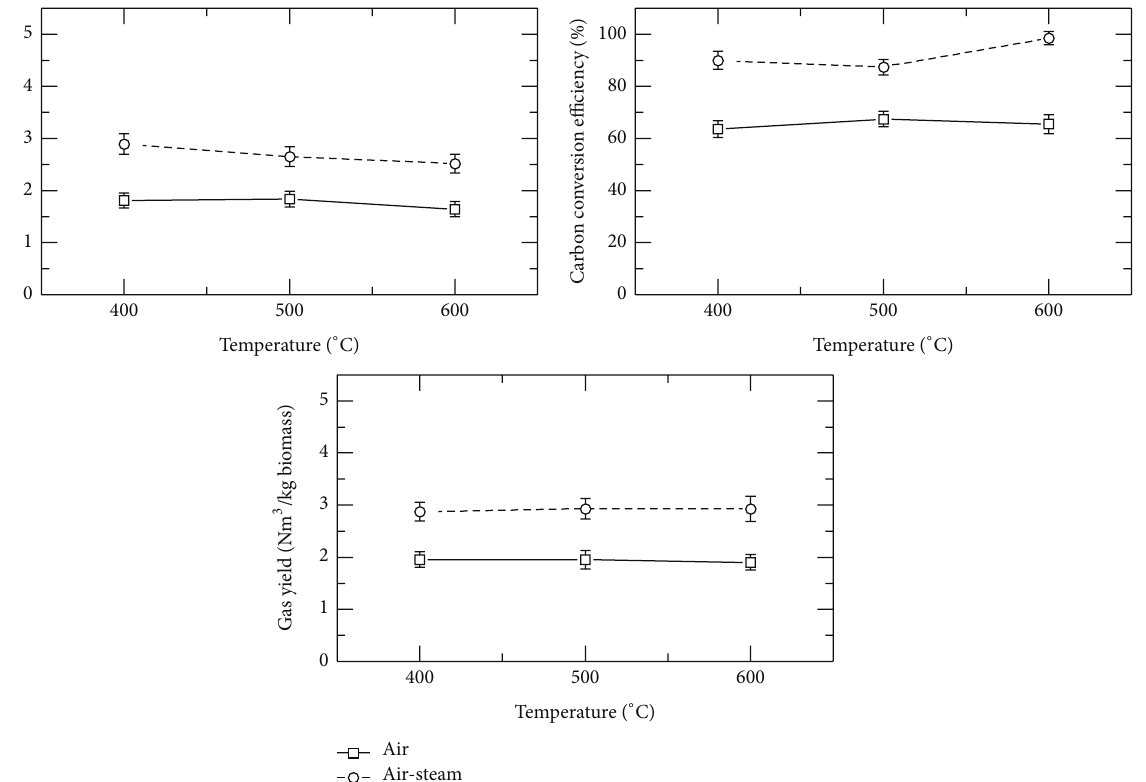
Figure 3: Effect of gasifying medium on LHV, carbon conversion efficiency, and gas yield at different temperatures.